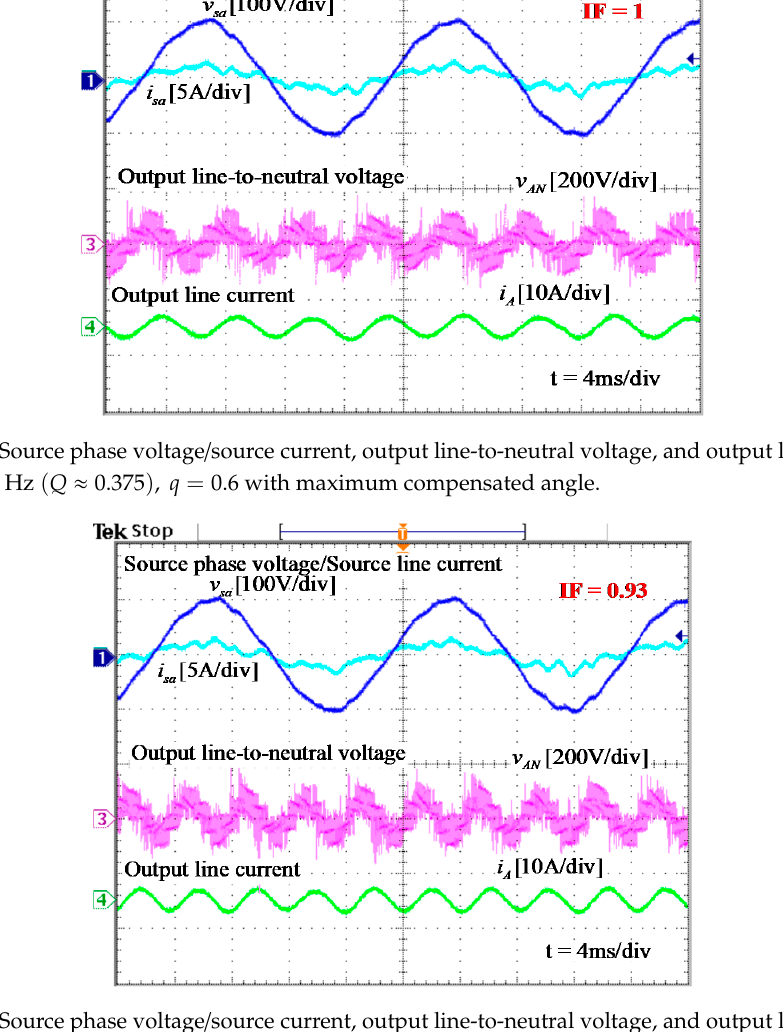
Figure 16. Source phase voltage / source current, output line-to-neutral voltage, and output line current at f o = 250 Hz ( Q = 0.54 > 0.375 ) , q = 0.7 with maximum compensated angle.